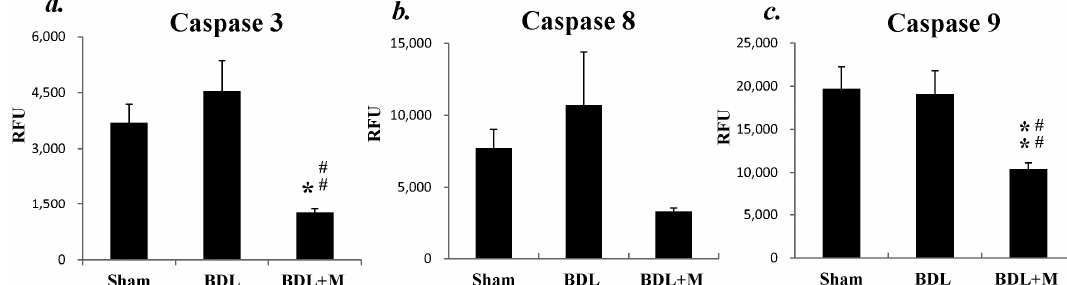
Figure 5. BDL for two weeks did not affect caspase 3 ( a ), caspase 8 ( b ), or caspase 9 ( c ) activities. Melatonin treatment decreased caspase 3 and caspase 9 activities. Significant difference among three groups was analyzed by one-way ANOVA followed by Bonferroni post hoc. All data are shown as mean ± SEM. * p < 0.05 vs. Sham; ** p < 0.01 vs. Sham; ## p < 0.01 vs. BDL. RFU: Relative fluorescence units.